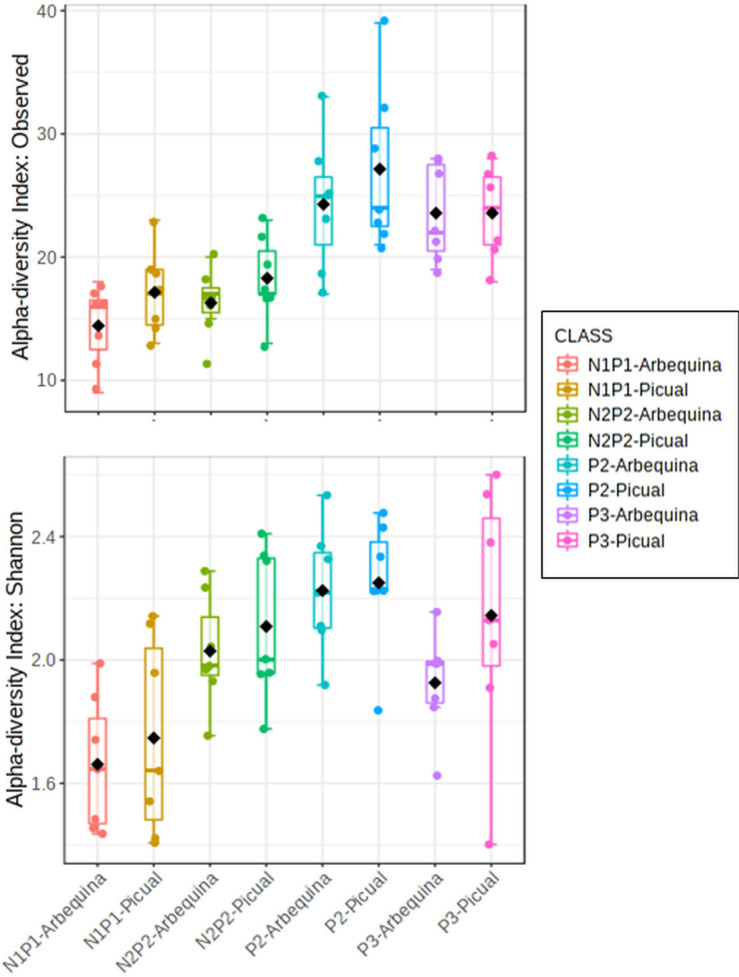
Boxplots of Richness and Shannon alpha diversity indices of xylem bacterial communities from “Picual” and “Arbequina” olive cultivars at operational taxonomic unit (OTU) taxonomic level determined by using different PCR primer pairs. Boxes represent the interquartile range, while the black dots inside the box define the median, and whiskers represent the lowest and highest values. P value was calculated using general linear modeling (GLM).